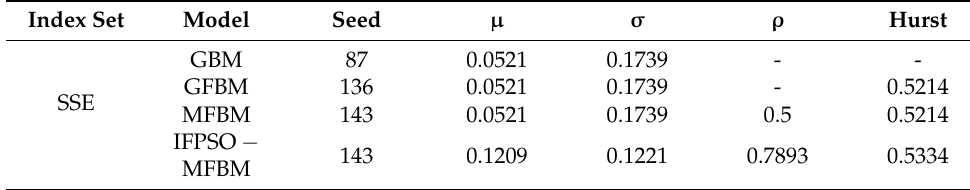
Table 3. Parameters of the SSE in the four